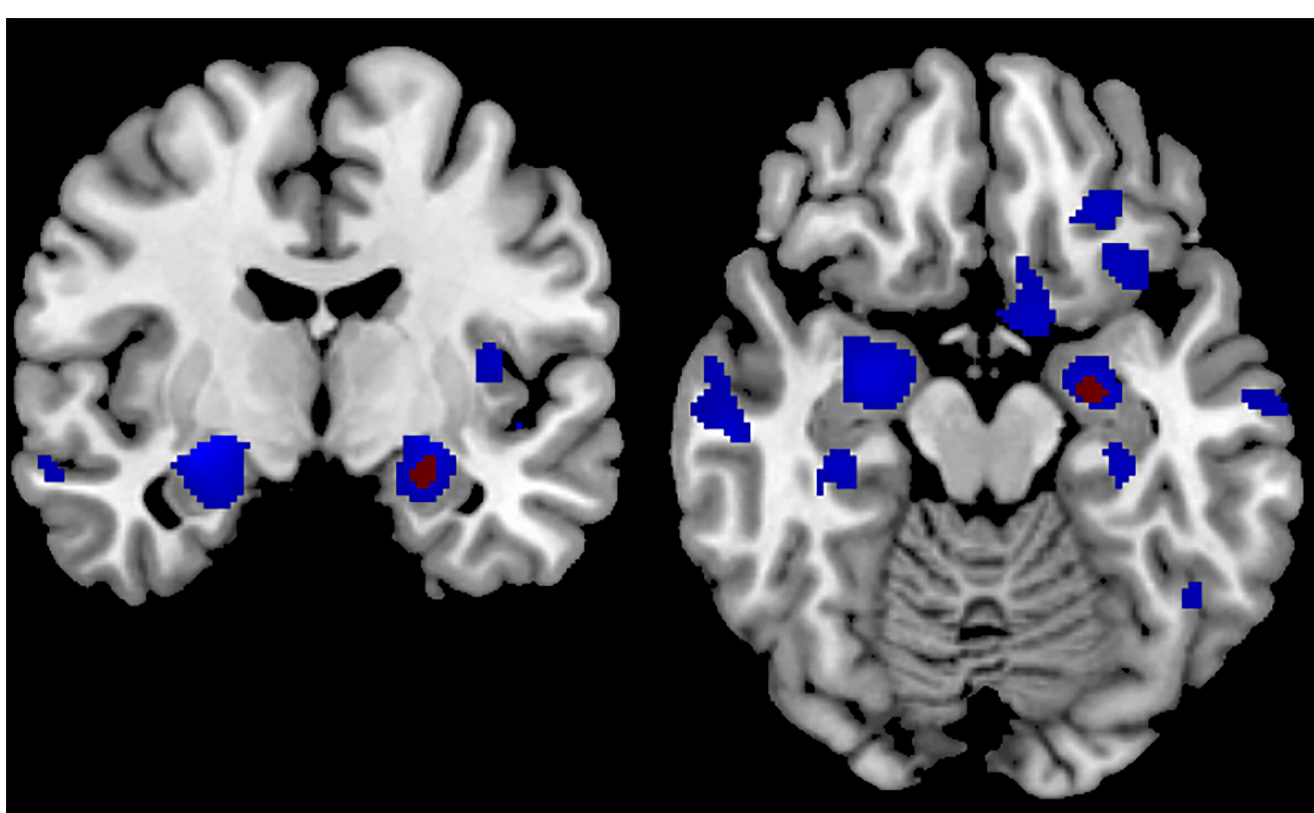
Fig 2. Gray matter regions showing a positive correlation with MMSE score (blue color) and SMMSE score (red color). The statistical map is co- registered and superimposed on 3D-T1-weighted axial (MNI coordinates y = -8) and coronal slices (MNI coordinatesz = -16) (MNI T1-weighted template availableon MRICRON software). Results are showed with a significance of P < 0.05 corrected for multiple comparisons